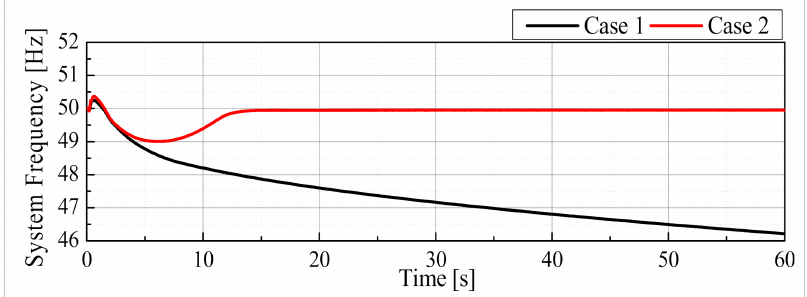
Figure 14. System frequency (Generating